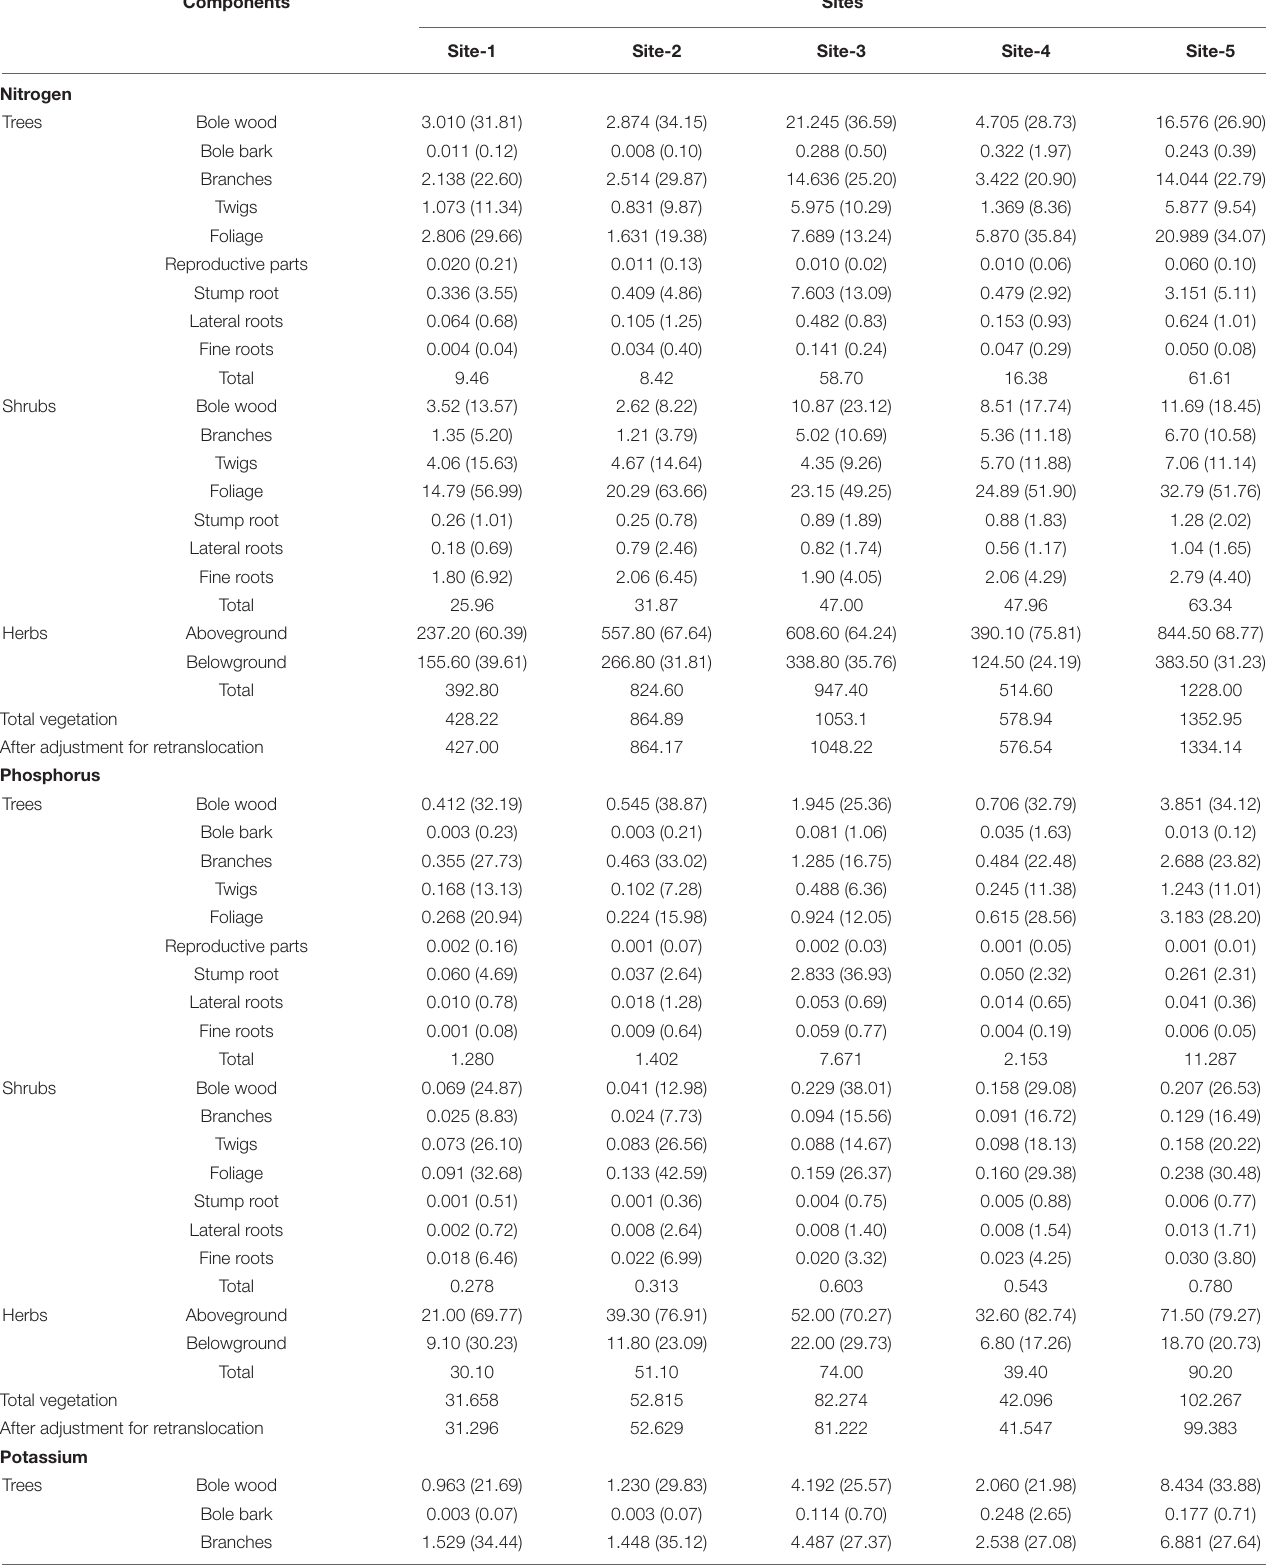
TABLE 5 | The uptake of nutrient (kg ha − 1 yr − 1 ) by different layers of vegetation across the selected sites (values in parenthesis are the percentage contribution).